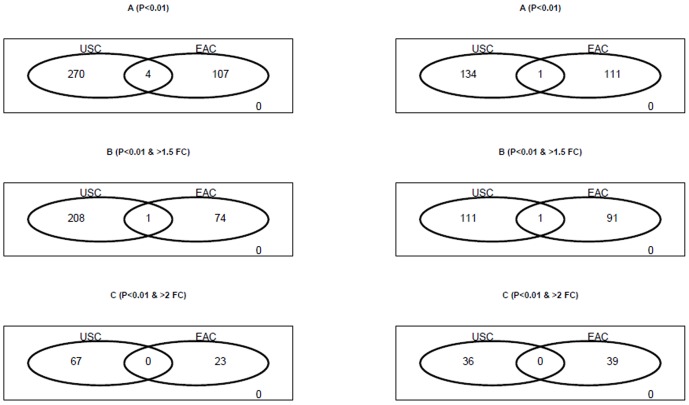
Venn diagrams show little overlap for DEGs derived from the USC and
EAC groups, respectively.
Left) DEGs from comparing late stage versus early stage
in the USC group and EAC group, respectively. Right)
DEGs from comparing good prognosis versus poor prognosis in the USC
group and EAC group, respectively. A) DEGs as defined by
P-value<0.01. B) DEGs with at least 1.5-fold change. C) DEGs with at
least 2-fold change.